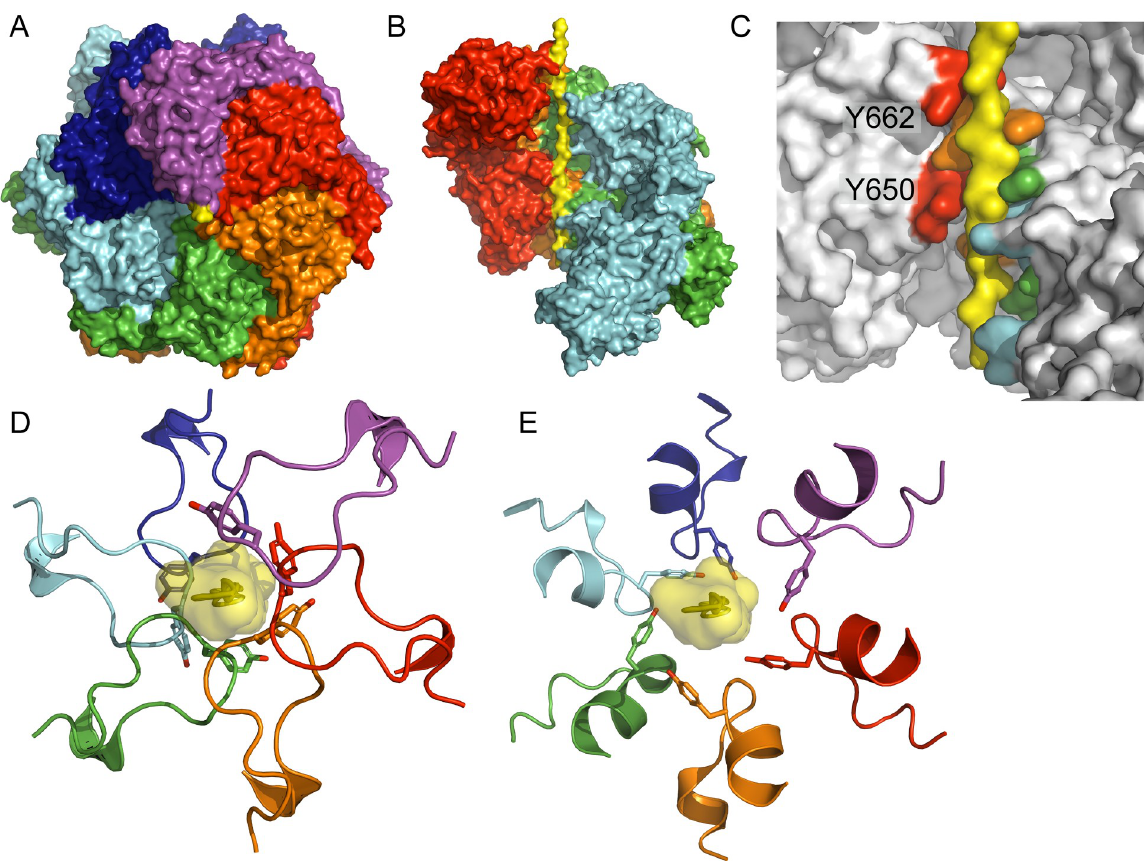
Fig 1. Substrate binding by Hsp104. Cryo-EM structures of (A) Hsp104 bound to casein(4). (B) Side view of the Hsp104 channel showing casein substrate (yellow). (C) Close up view of Hsp104 channel showing confirmed substrate binding residue Y662 and putative substrate binding residue Y650. (D) Interactions between Y662 residues (sticks) and casein (yellow). (E) Interactions between Y650 residues (sticks) and casein (yellow). Generated in PyMol using PDB: 5VYA[4].